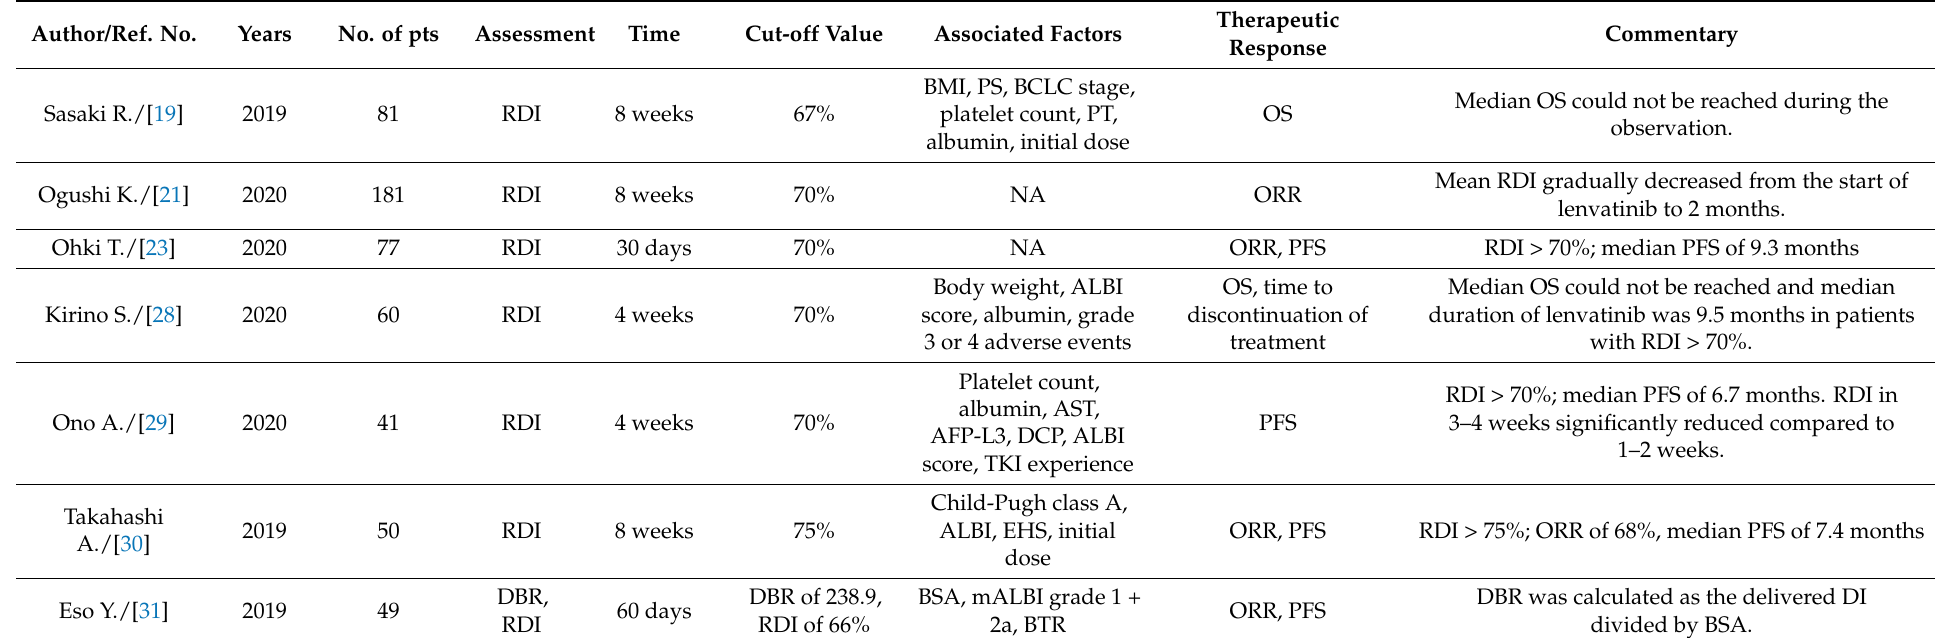
Table 2. Reports associated with dose